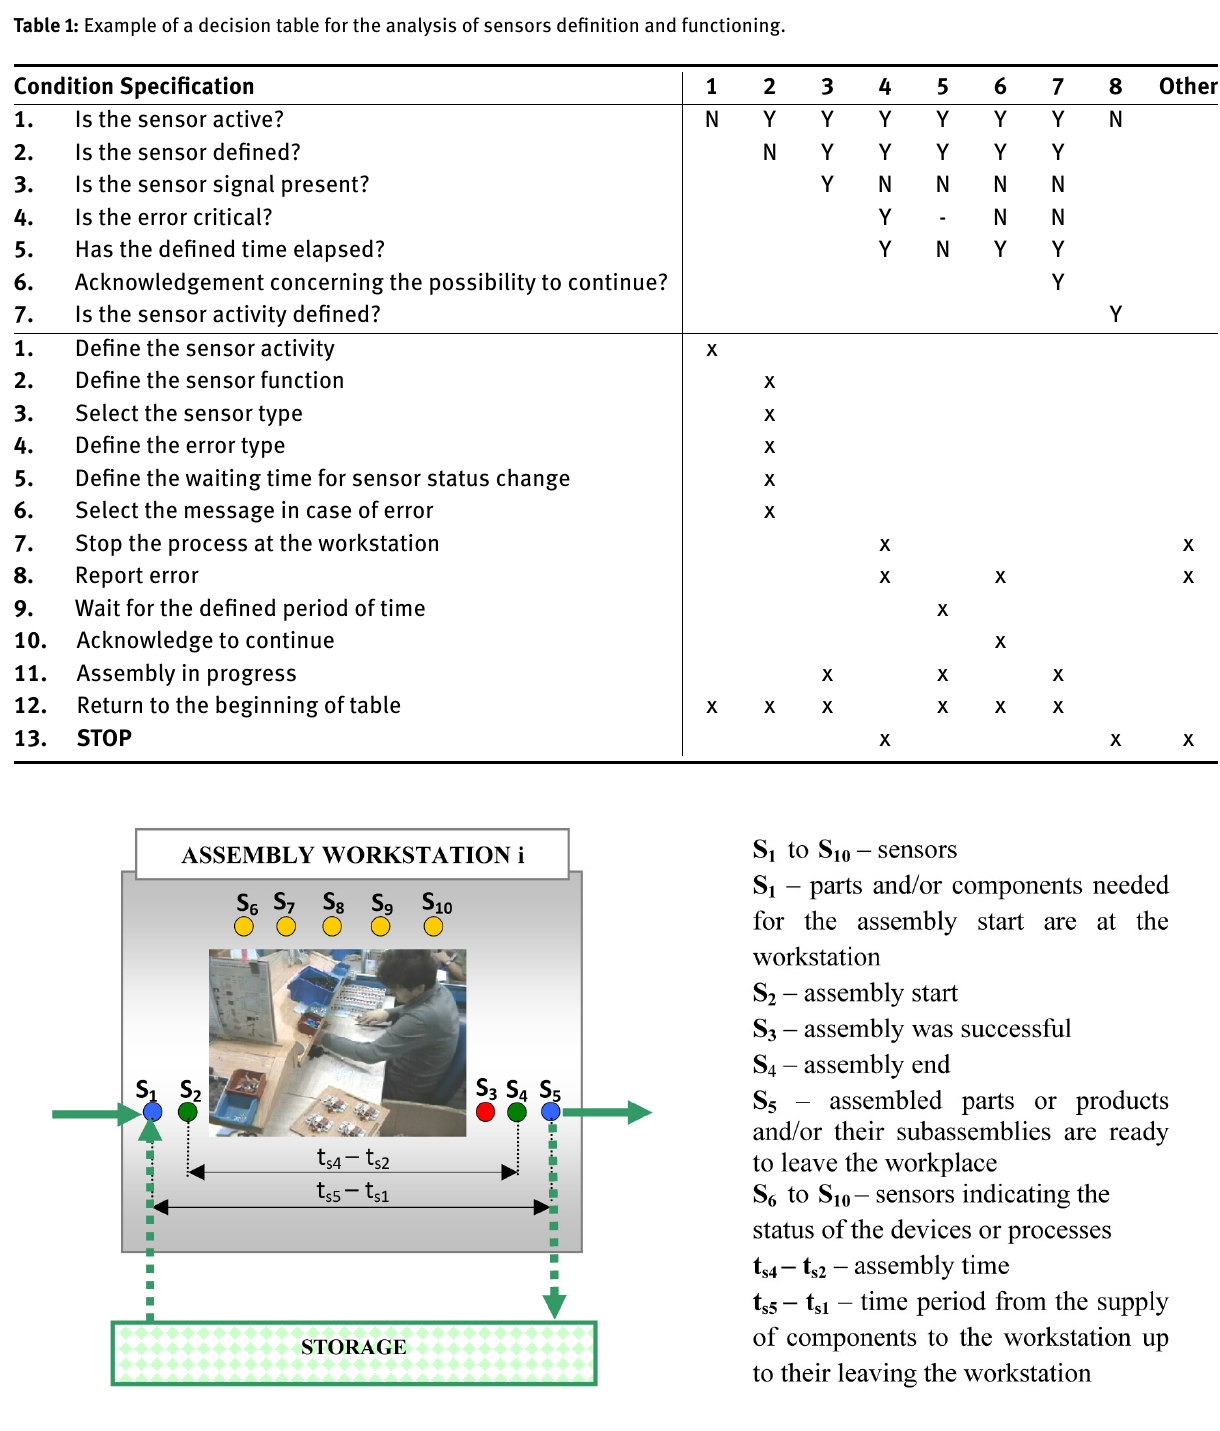
Figure 1: Basic characteristics of the on-line analysis model.